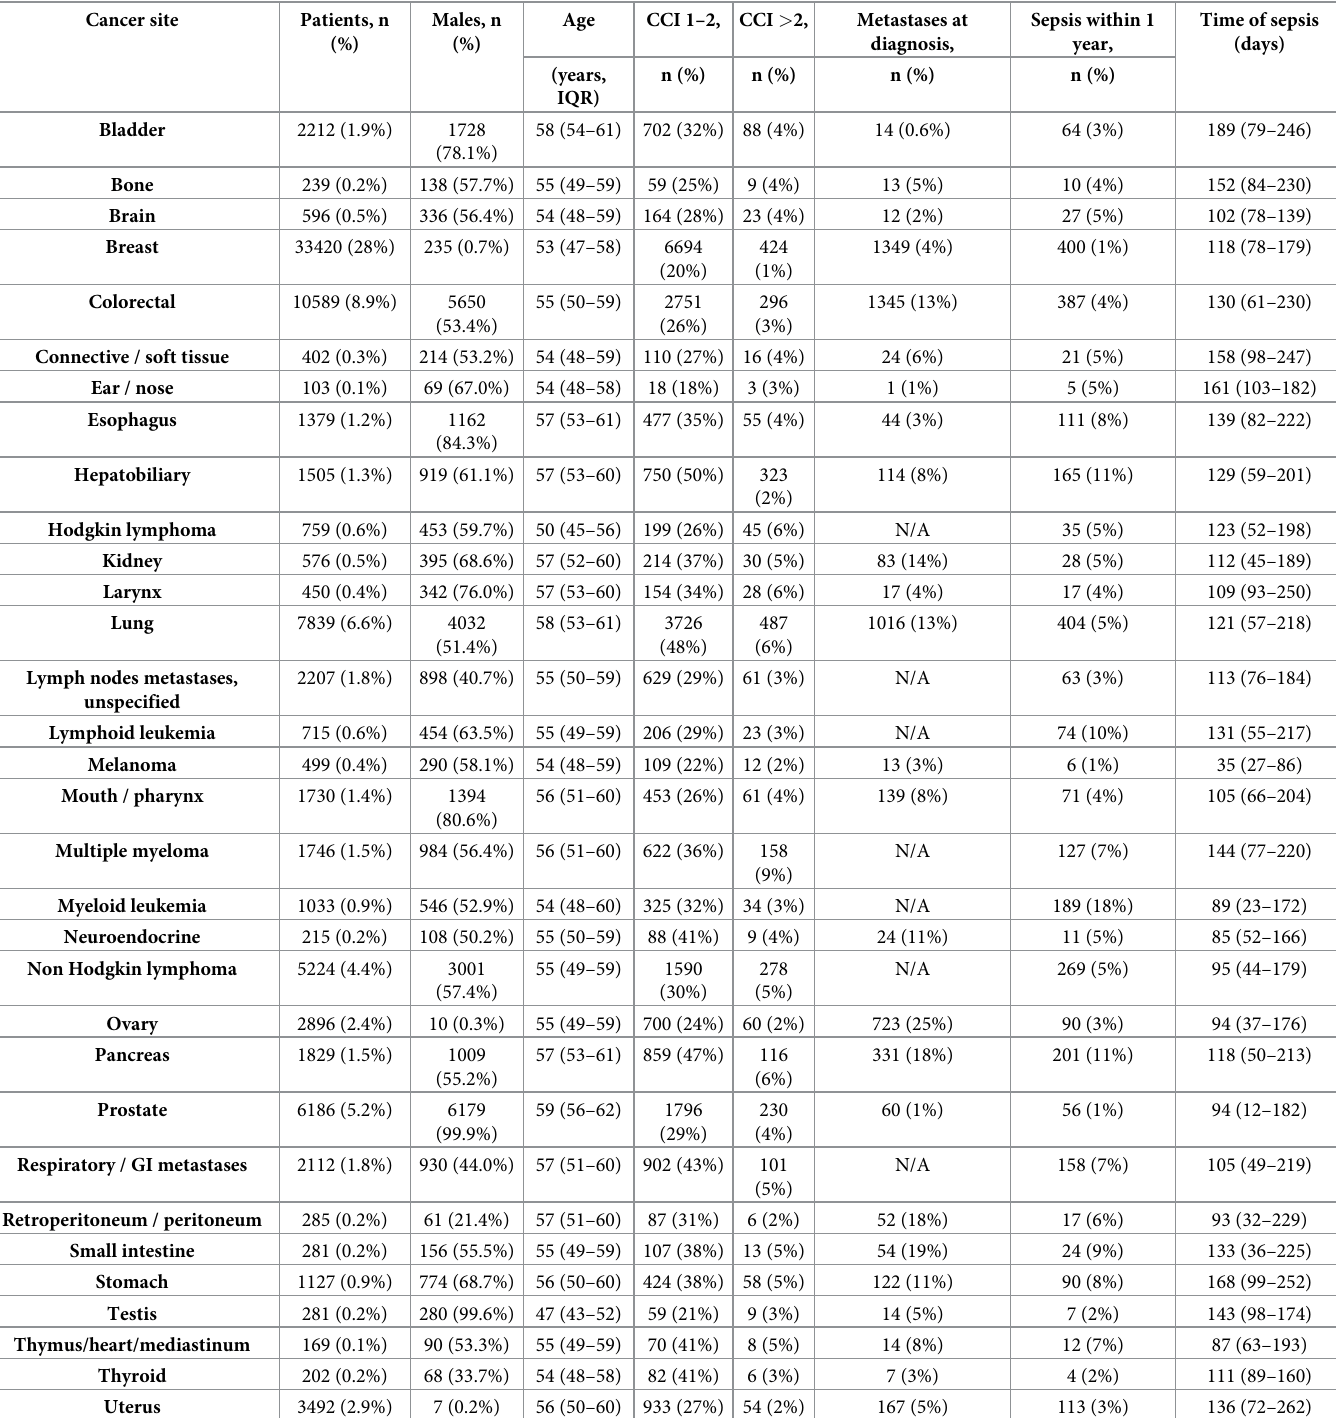
Table 1. Characteristics of the 119,379 patients with cancer included in the study between 2005 and 2014, based on specified cancer